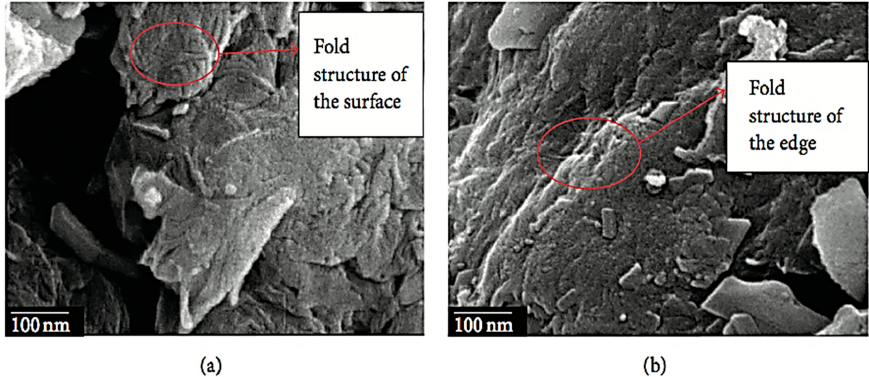
Figure 5. ( a , b ) SEM micrograph of synthesized Gp. Reprinted with permission from [66]. Copyright MDPI Publishers, 2015.